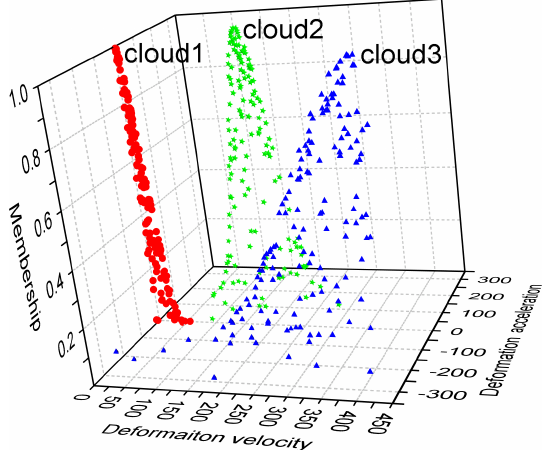
Figure 4. Regenerated clouds of each cluster.